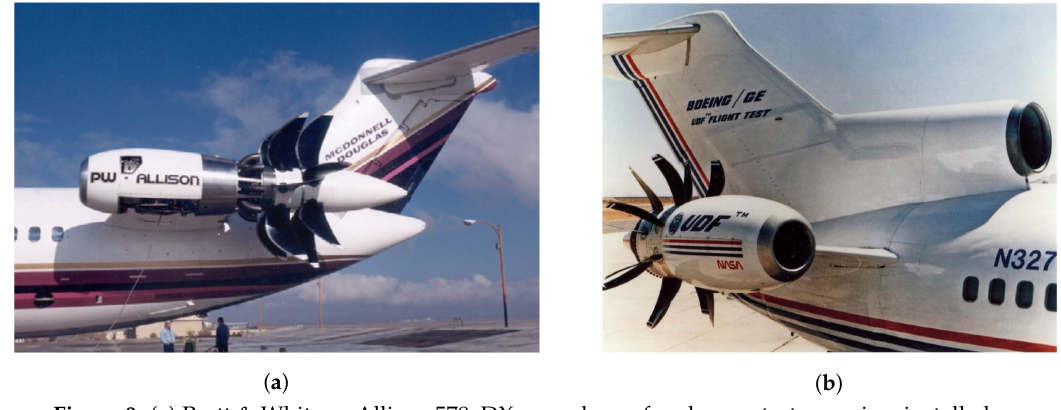
Figure 9. ( a ) Pratt & Whitney-Allison 578–DX geared propfan demonstrator engine, installed on an MD-80 testbed aircraft. ( b ) General Electric GE36 demonstrator engine installed on the Boeing 727 testbed for flight testing in